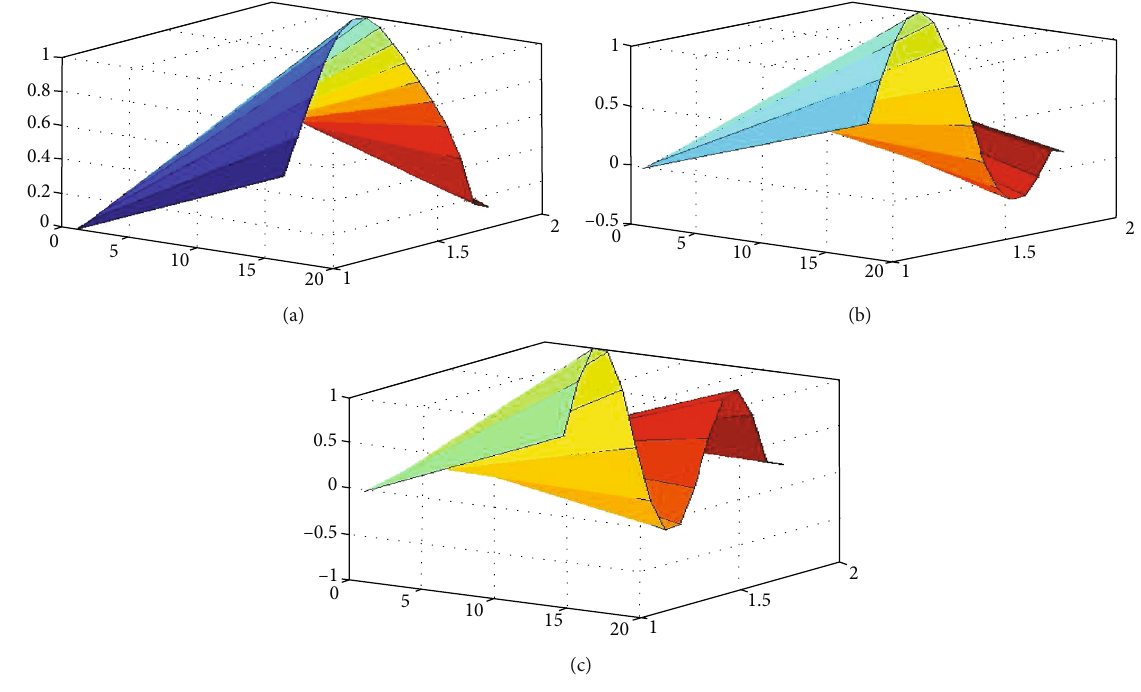
Figure 13: (a – c) Mode shapes of cross-ply annular circular plate ( W